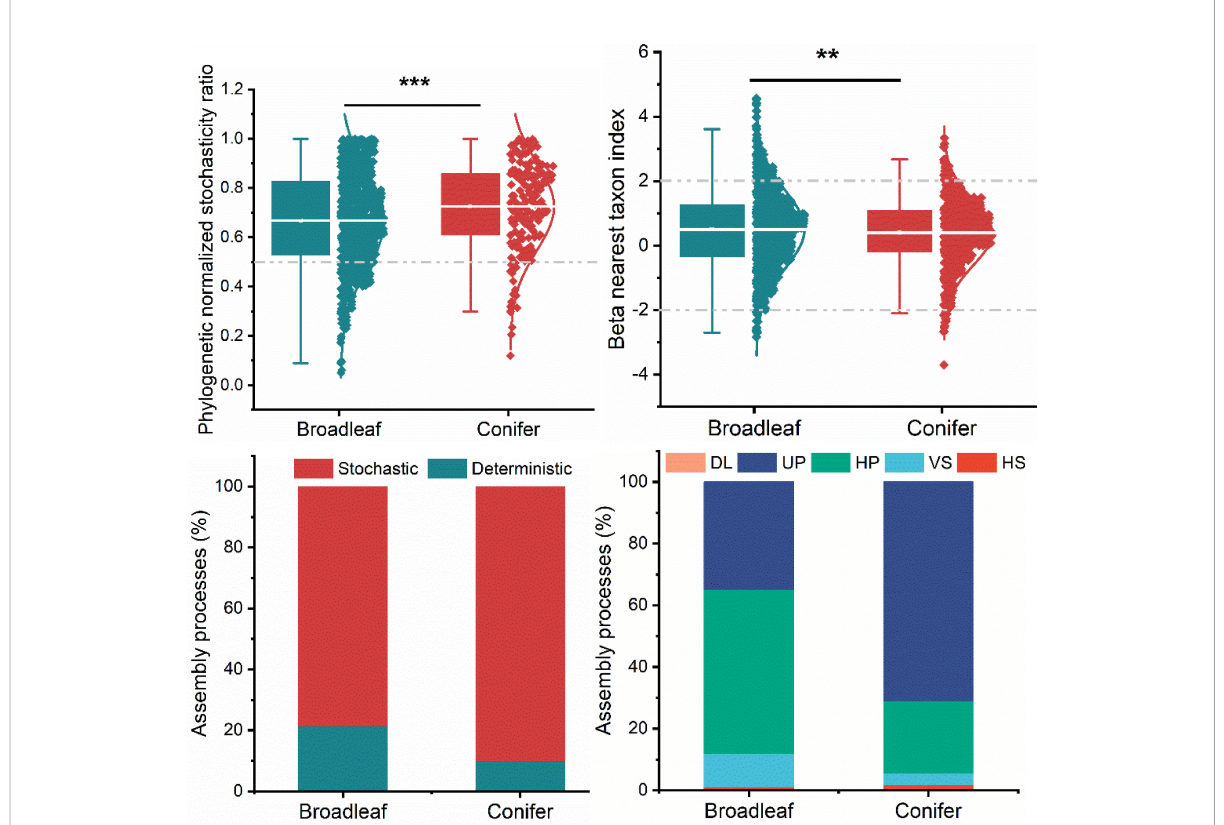
FIGURE 4 Deterministic vs. stochastic assembly processes in broadleaf and coniferous trees based on phylogenetic normalized stochasticity ratio (pNST) and beta nearest taxon index ( b NTI). Stochastic processes: DL, dispersal limitation; UP, undominated processes; HP, homogenizing dispersal; deterministic processes: VS, variable selection; HS, homogeneous selection. The non-dominant processes (|RCbray|<0.95) were drift and diversi fi cation P < 0.01 = **, P < 0.001 =